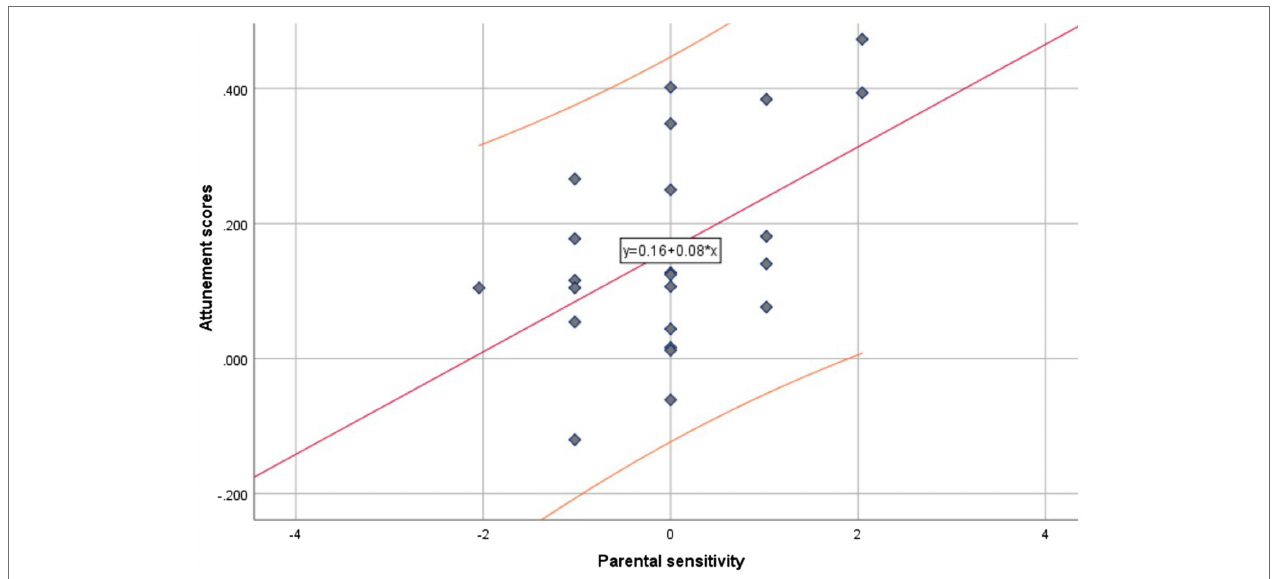
FIGURE 2 | TS sample. Regression slope (red) with confidence interval (orange) of the parental sensitivity scores ( x -axis) predicting attunement scores ( y